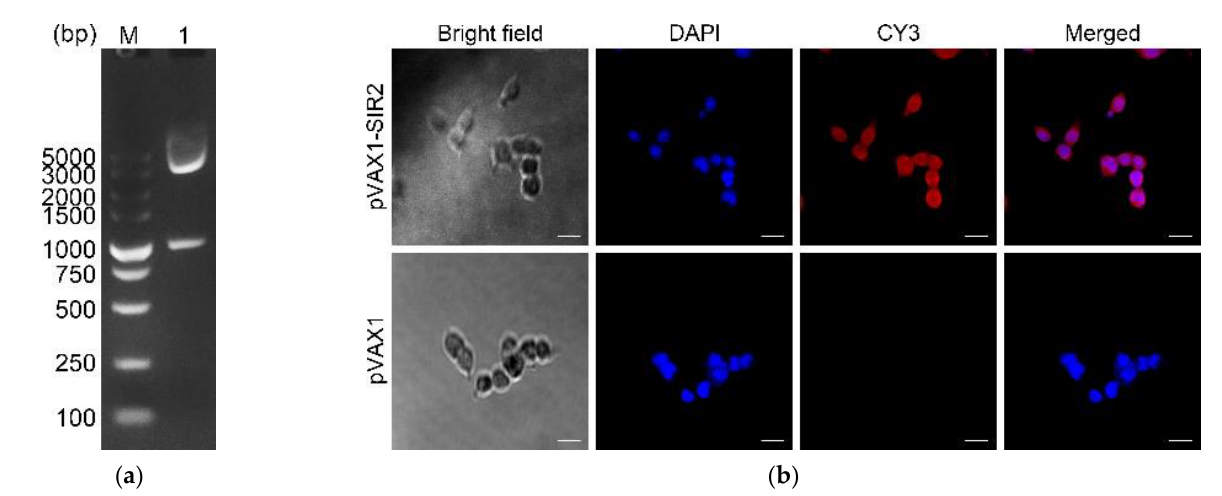
Figure 1. ( a ) Double digestion analysis of the recombinant plasmid pVAX1-SIR2. Line M: DL5000 marker; Line 1: Double digestion with Eco RI and Xho I. ( b ) Fluorescent microscopy imagines of HEK 293-T cells transfected with pVAX1-SIR2 and pVAX1 plasmids. Cells were detected by sera from rats against rTgSIR2 protein. Bar represents 25 μm.